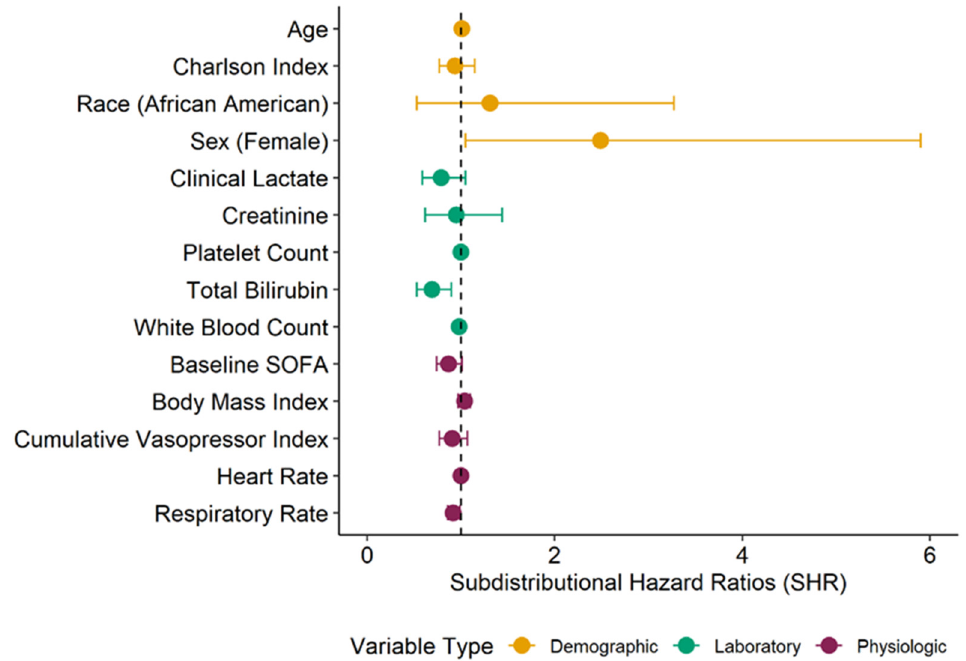
Figure 2. Comparison of time to successful extubation and freedom from vasopressors based on patient characteristics at baseline. The unadjusted subdistributional hazard ratio (SHR) was deter- mined for demographic, clinical laboratory, and physiologic characteristics of patients at time of enrollment. The SHR was determined using a competing risk survival model for time to extubation and freedom from vasopressors, with death in the first 28 days as a competing risk. Here, an SHR < 1 indicates that, with increases in the predictor variable, there is a lower incidence of intact extubation and freedom from vasopressors. Female sex and African American self-reported race were coded as 1, while male sex and Caucasian race were coded as 0. Complete data (N = 47) were available for all variables except race (N = 46); clinical lactate (N = 37); platelet count and cumulative vasopressor index (N = 46); and white blood count (N = 34). Patient characteristics can be found in Supplementary Table